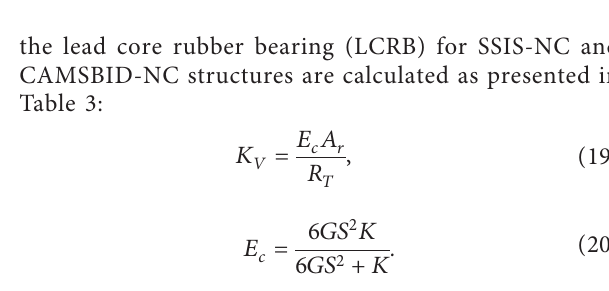
Figure 9: Top-level acceleration responses of SSIS-NC (blue) in comparison with CAMSBID-NC (green) and input acceleration (red) under the effect of 2011 Tohoku (a, b) and 2010 El Mayor (c, d)